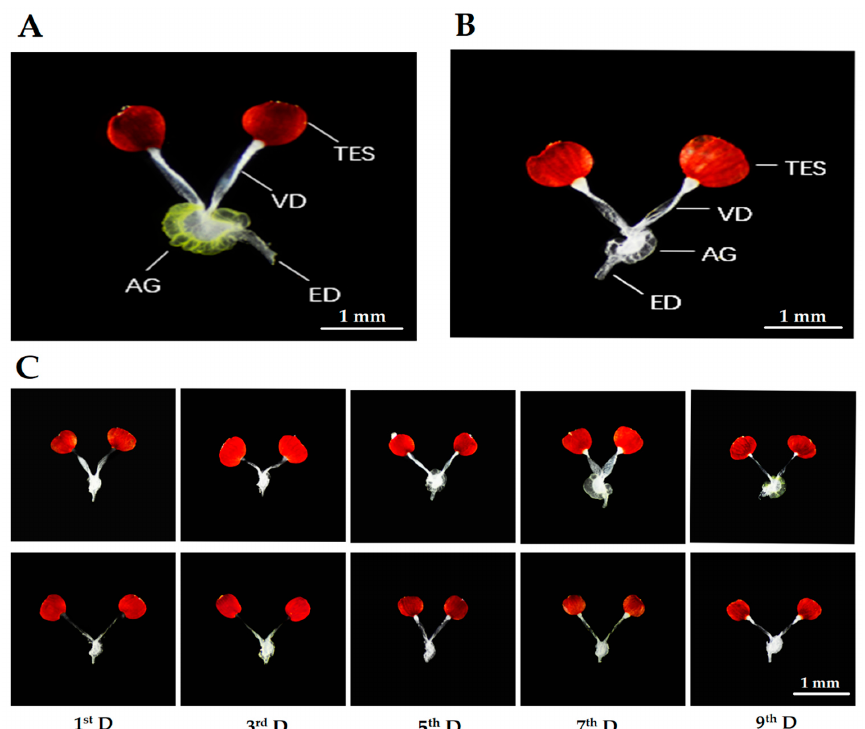
Figure 3. Development of internal reproductive organs of prereproductive ( A ) and prediapause ( B ) males after 9 days of adult emergence. Differences in the development of prereproductive (upper) and prediapause (lower) of R. pedestris male adultsat each day of observation ( C ). Accessory gland (AG), vas deferens (VD), testis (TES), ejaculatory duct (ED).